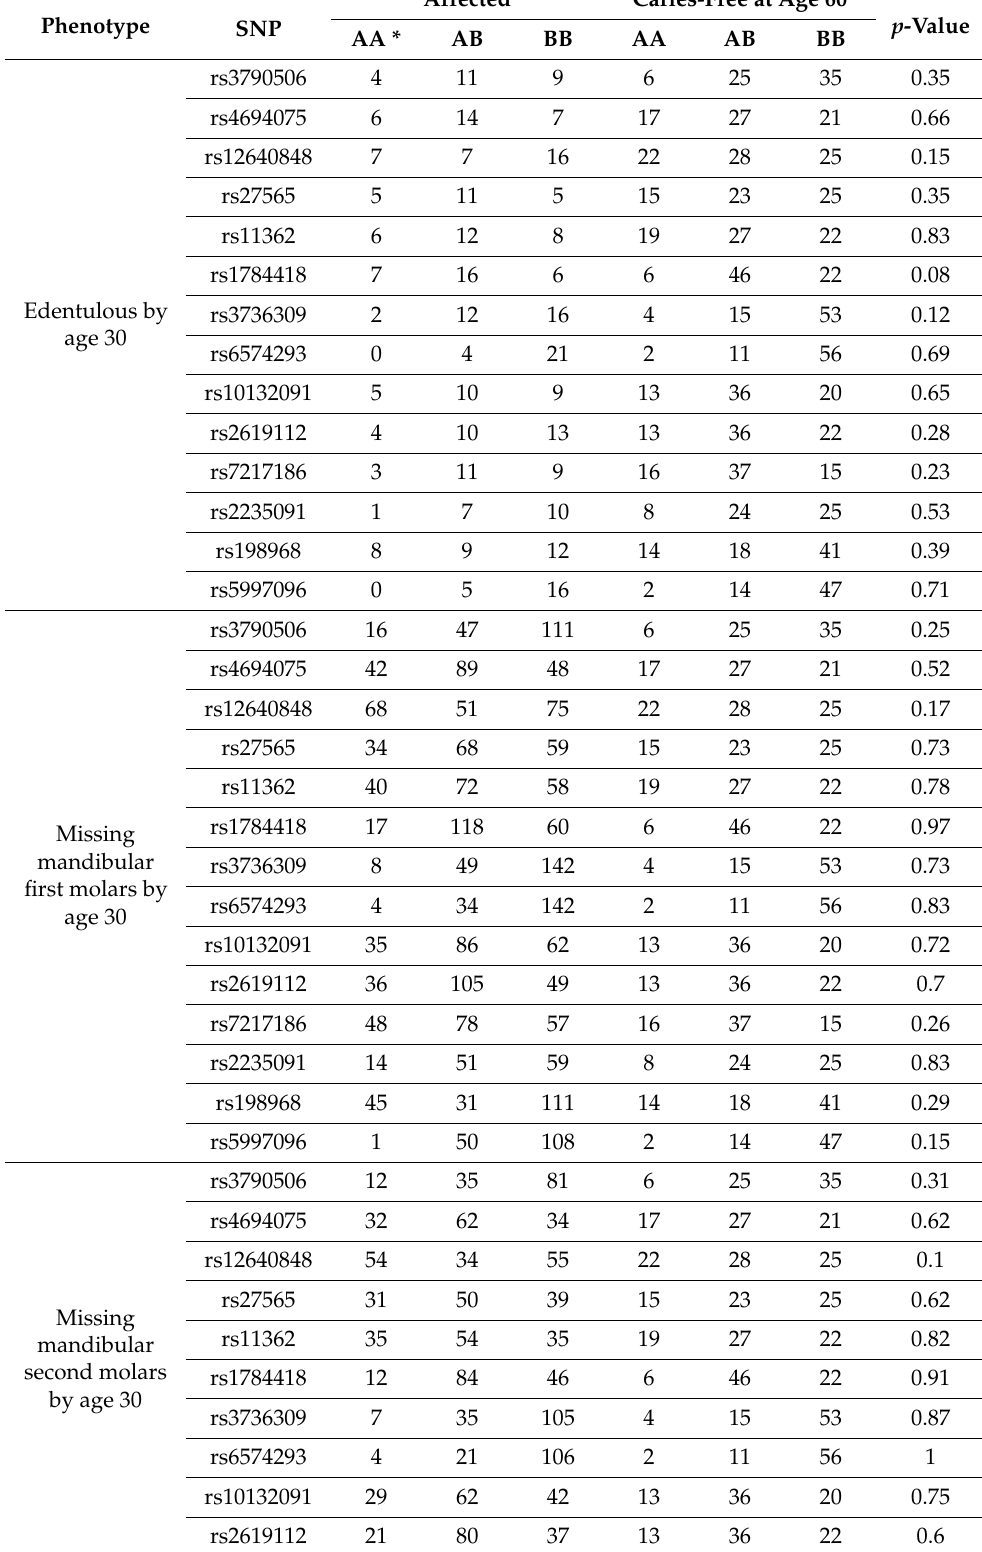
Table 2. Genotyping distribution per tested